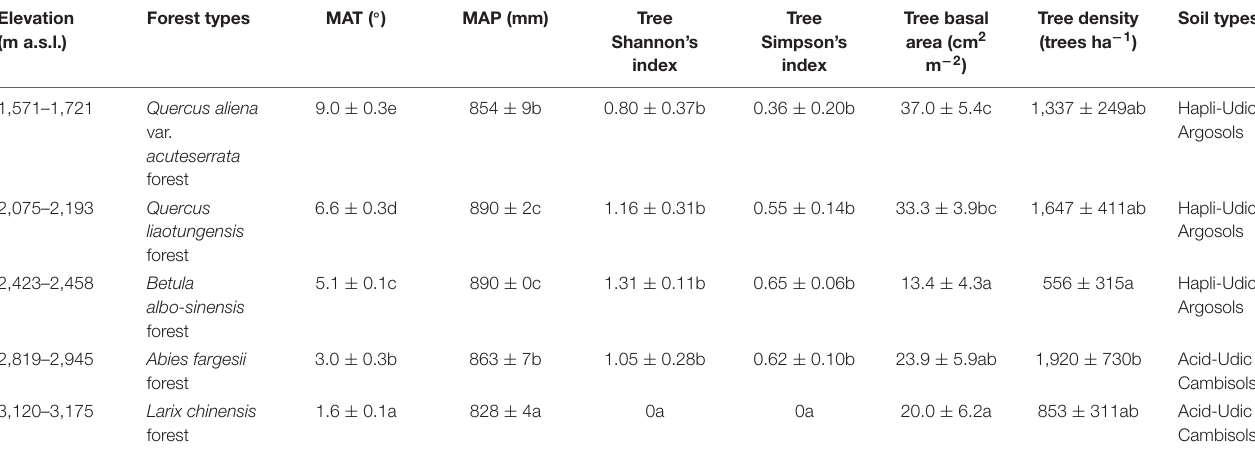
TABLE 1 | The properties of the sampling sites along the northern slope of Taibai Mountain. Elevation (m